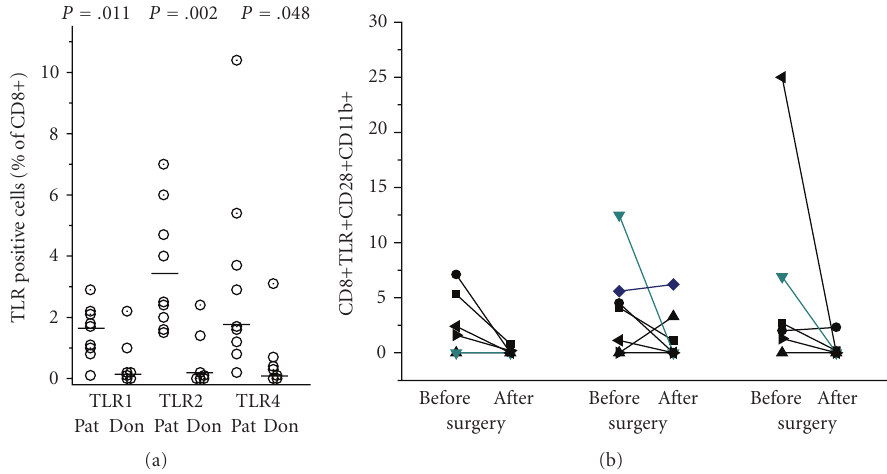
Figure 5: Expression of TLR on peripheral CD8+ cells in patients with implant-associated osteomyelitis and in healthy donors: (a) by cytofluorometry, expressions of TLR1, TLR2, and TLR4 on CD8+ cells was determined. Each dot represents a patient or a donor, respectively. The horizontal bars represent the median values. The mean values for TLR2 and TLR4 were di ff erent between patients and donors as calculated by ANOVA. (b) CD8+CD28+CD11b+ expressing TLR1, TLR2, or TLR4 were quantified by cytofluorometry at the day of surgery (before) or 6 to 8 days later (after) when the infection was resolved. Each symbol refers to an individual patient; the line connects the values before and after